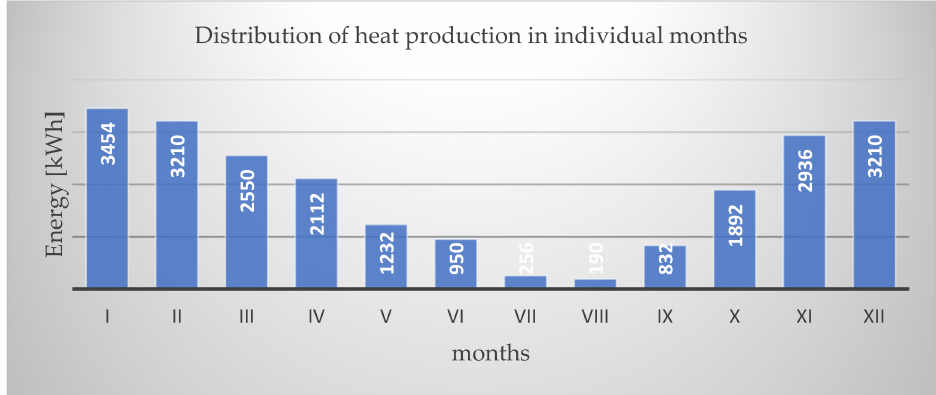
Figure 1. Distribution of heat production in individual months. Source: own